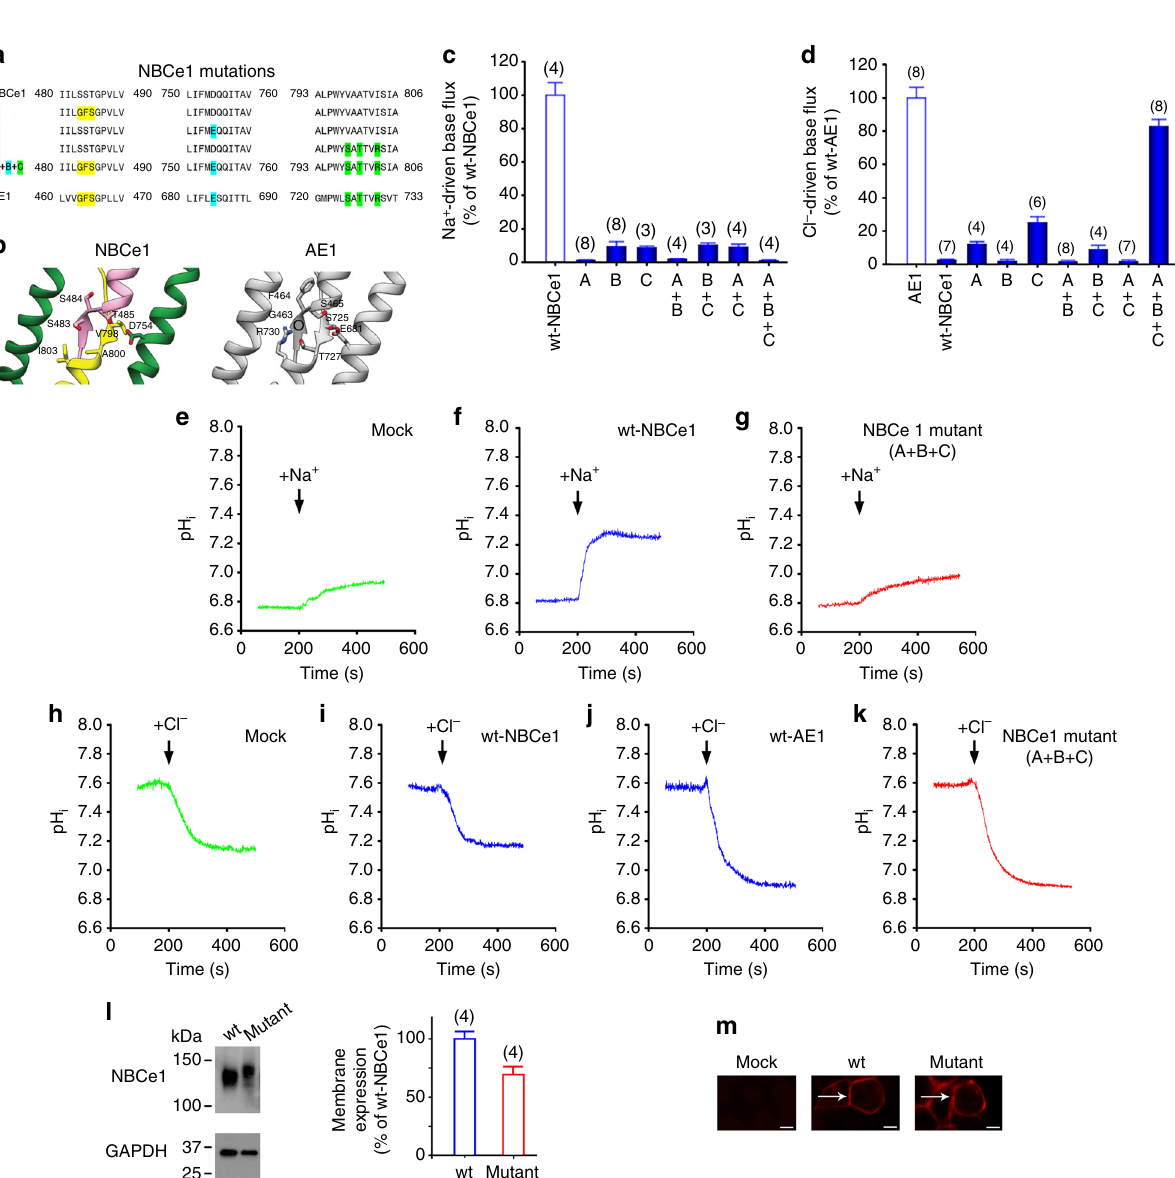
Fig. 4 Conversion of NBCe1 into an anion exchanger. a NBCe1 and AE1 amino-acid alignment showing location of the NBCe1 residues replaced with the corresponding AE1 residues. b Location of the NBCe1 residues replaced with the corresponding AE1 residues located in ion coordination site regions of NBCe1 and AE1 22 (PDB: 4YZF) formed by antiparallel β -strands preceding TMs 3 and 10, and in TM 8 and 10 are shown. c, e-g Loss of Na + -driven base transport and d, h-k gain of Cl − -driven base transport in the mutant constructs. l , m Cell surface expression. Immunoblot analysis of sulfo-NHS-SS-biotin labeled plasma membrane proteins in HEK-293 cells-expressing wt-NBCe1 and NBCe1 mutant (A + B + C). l Cell surface expression was normalized to GAPDH (mutant vs. wt, p < 0.05; one-way ANOVA followed by Tukey ’ s test). m Immunocytochemistry of HEK-293 cells showing plasma membrane localization of the wt and NBCe1 mutant (A + B + C) transporters, scale bars 5 µ m. c , d , l The mean ± s.e.m. is depicted. The number of experiments is shown in The fi nal cryoEM map was sharpened with B-factor and low-pass fi ltered to the The particles were fi rst subjected to 3D classi fi cations by GPU-accelerated stated resolution using RELION-2. The local resolution was calculated by RELION-2 58,59 using an oval-shaped disk low-pass fi ltered to 60Å as the initial ResMap 60 using two cryoEM maps to independently re fi ne from halves of the data. model. The particles were separated into six classes for 69 iterations and the best class contained 687,322 particles, which were then sent to a second run of 3D classi fi cation to be sorted into fi ve classes. A number of 214,196 particles were Model building and re fi nement and structure visualization . The overall 3.9Å found in the best class after 60 iterations of the second run of 3D classi fi cation. A twofold symmetry was enforced in the above 3D classi fi cations. 3D classi fi cations cryoEM structure was at a suf fi cient resolution to build a de novo atomic model for without symmetry (i.e., C1) were also tested but no further improvement on the separation of heterogeneity was found. The 214,196 particles were then sent to 2D classi fi cation using RELION-2 and sorted into 200 classes for 72 iterations. A total number of 184,561 particles in 134 good classes that show discernible high-resolution features such as α -helices were combined for 3D auto-re fi nement. The 3D auto-re fi nement was performed using a spherical mask (180Å in diameter) by RELION-2. The resolution was estimated to be 3.9 Å by relion_postprocess in continued with side chain placements into the protrusions visible in the helical RELION-2 with a soft auto-mask using the ‘‘ gold-standard ’’ FSC at 0.143 criterion. densities. Aromatic residues including Phe443, Phe461, Phe471, Phe474, Phe791,